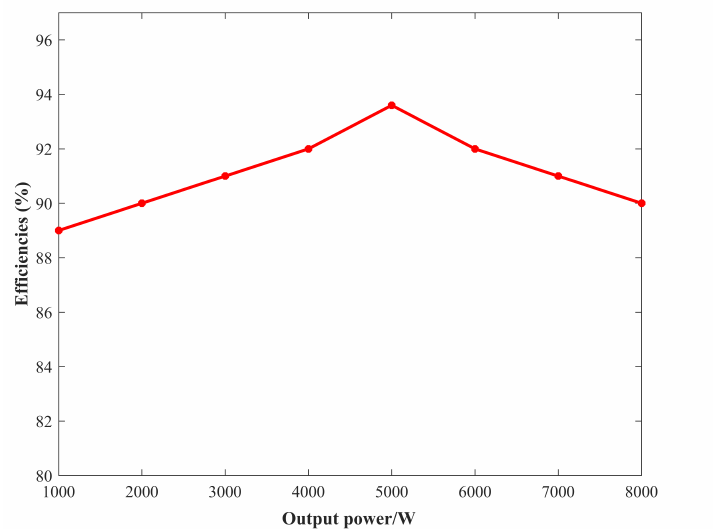
Figure 12. Efficiency of the converter at various output